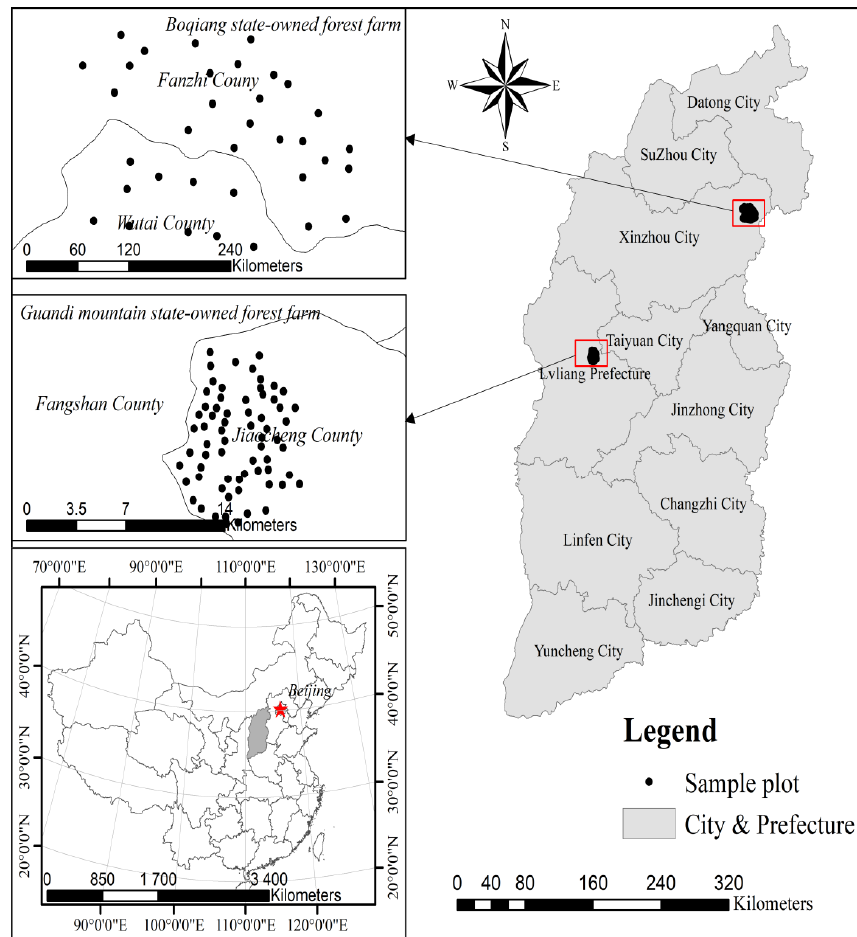
Figure 1. Study area showing the sample plot location.